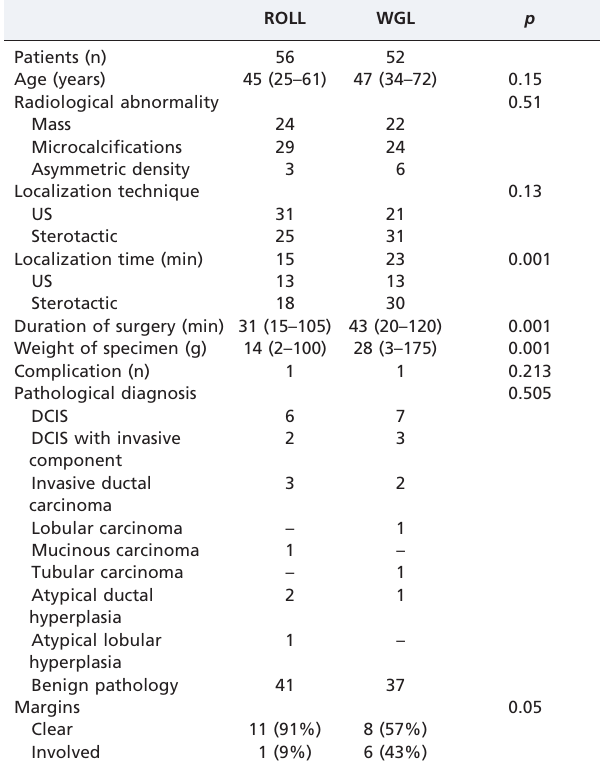
Table 1 - Clinical, radiological and pathological features of